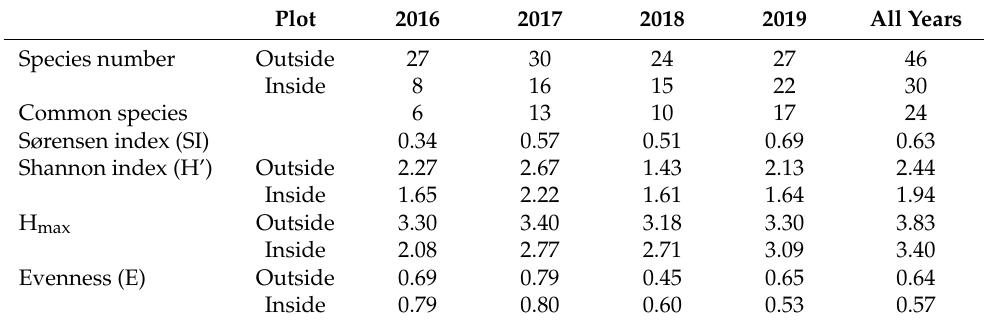
Table 2. Species numbers, Sørensen index, Shannon index, and Evenness of bee communities collected in coloured pan traps placed inside and outside the netted plot of apple trees during the flowering period in the years 2016–2019.